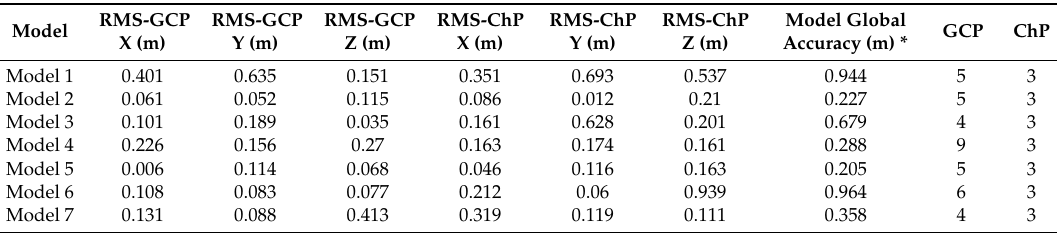
Table 2. Ground Control Points and Ground Check Points accuracy data. * Model global accuracy according to Gonz á lez-D í ez